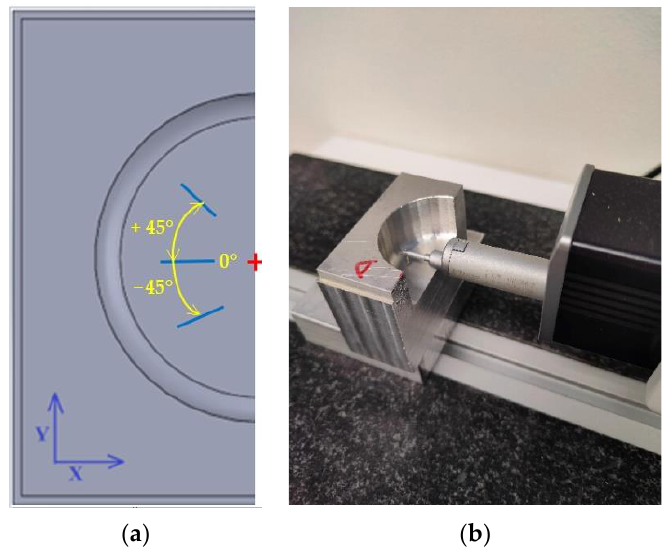
Figure 11. Surface texture observation area ( a ) CAD model ( b ) machined part. Figure 11. Roughness measurement area ( a ) CAD model ( b ) test